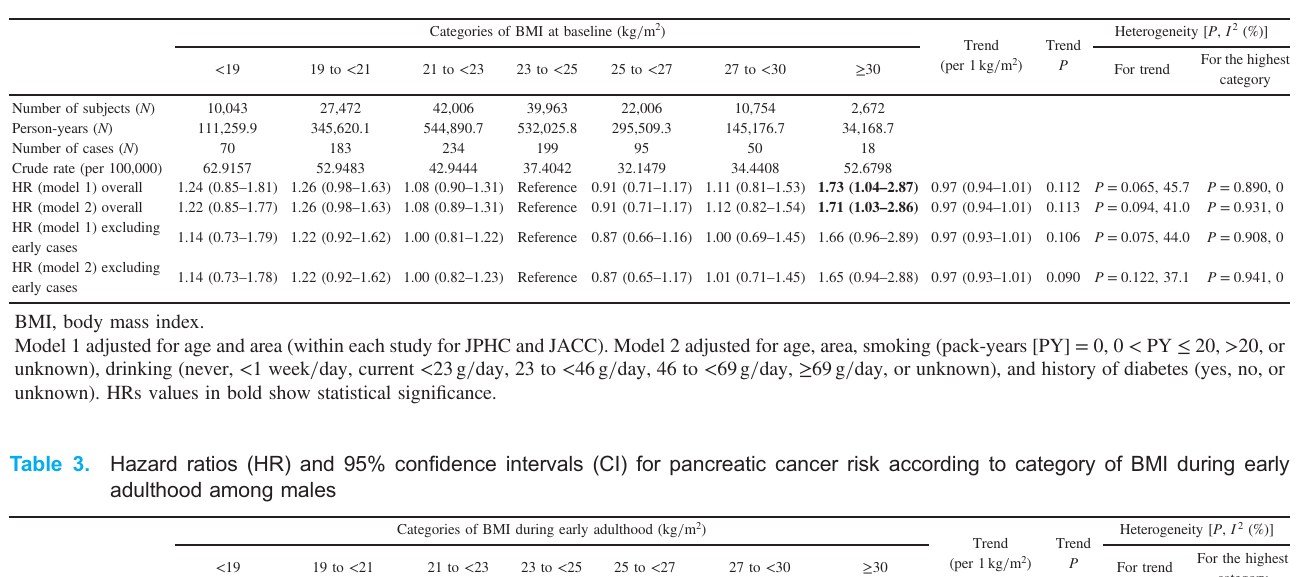
Heterogeneity [ P , I 2 (%)] Trend Trend P (per 1kg = m 2 ) For trend For the highest category